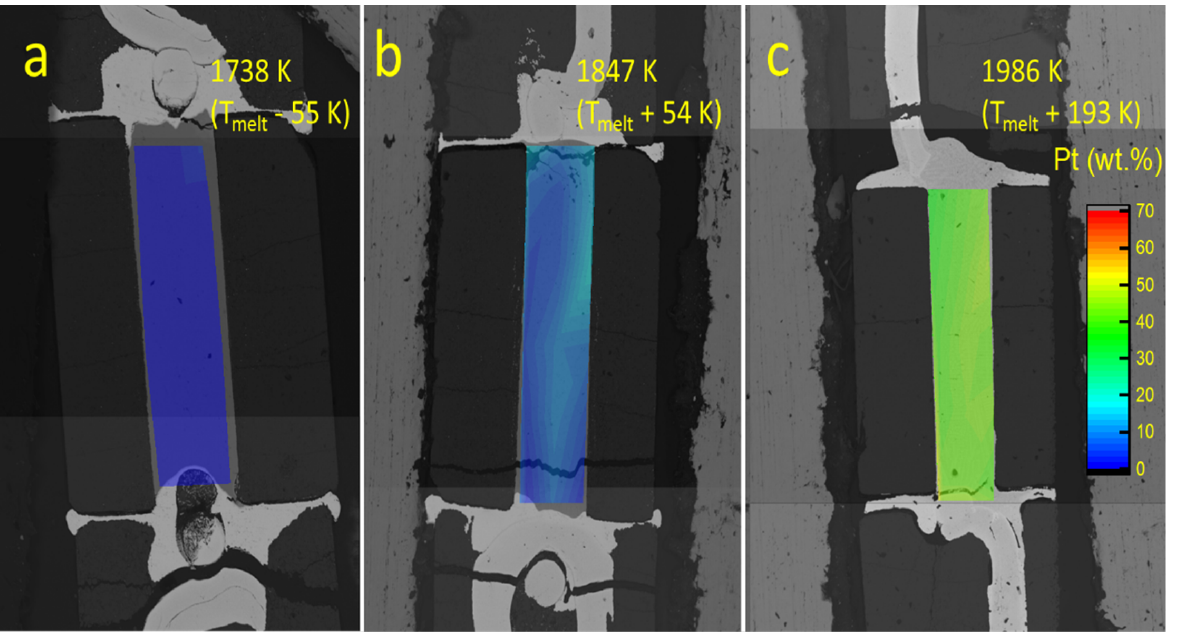
Figure 3. Chemical composition of Fe-5 wt% Ni recovered from three separate experiments at 4 GPa that reached maximum T of: ( a ) 1738 K (T melt − 55 K); ( b ) 1847 K (T melt + 54 K); and ( c ) 1986 K (T melt + 193 K).